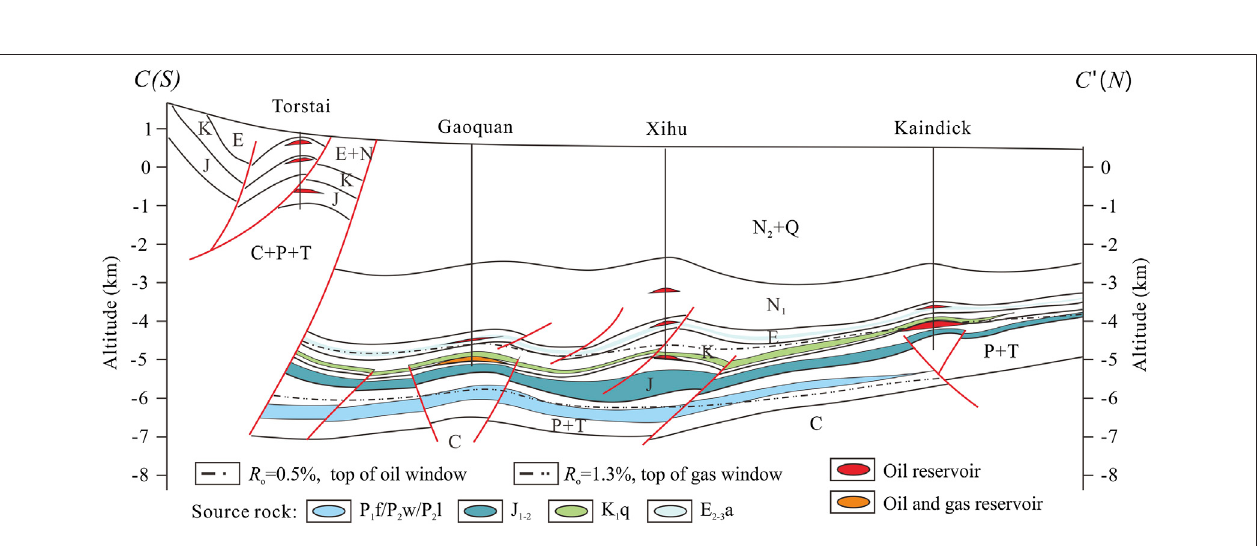
Frontiers in Earth Science |